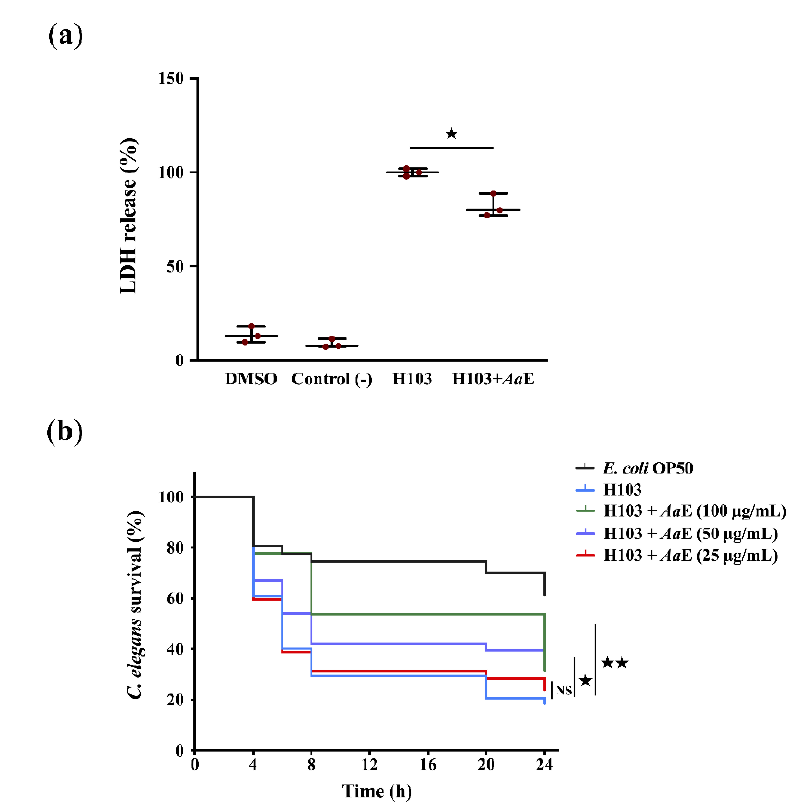
Figure 1. Anti-virulence effect of A. atacamensis extract ( Aa E) against P. aeruginosa on A549 human lung cells and C. elegans infection models. ( a ) Virulence attenuation on P. aeruginosa by Aa E evaluated by using human A549 lung cells infection model. The presence of Aa E (100 µg/mL) significantly protected A549 lung cells from lysis after 20 h infection. Data are presented as the mean ± SEM values of three independent experiments performed in duplicate. ★ , p = 0.01–0.05 (two-tailed t- test) versus untreated H103 cells. ( b ) P. aeruginosa H103 virulence attenuation in a C. elegans infection model by Aa E. Sixty L4-stage nematodes per experimental group were placed on lawns of E. coli OP50 (black) or H103 strain in the absence (red) or presence of Aa E at 25, 50 and 100 µg/mL (green). Alive C. elegans nematodes were scored at 4, 6, 8, 20, and 24 h after the start of the assay. ★★ , p = 0.001–0.01; ★ , p = 0.01– 0.05; NS: (not significant), p > 0.05 (log-rank [Mantel-Cox] test) versus control condition.